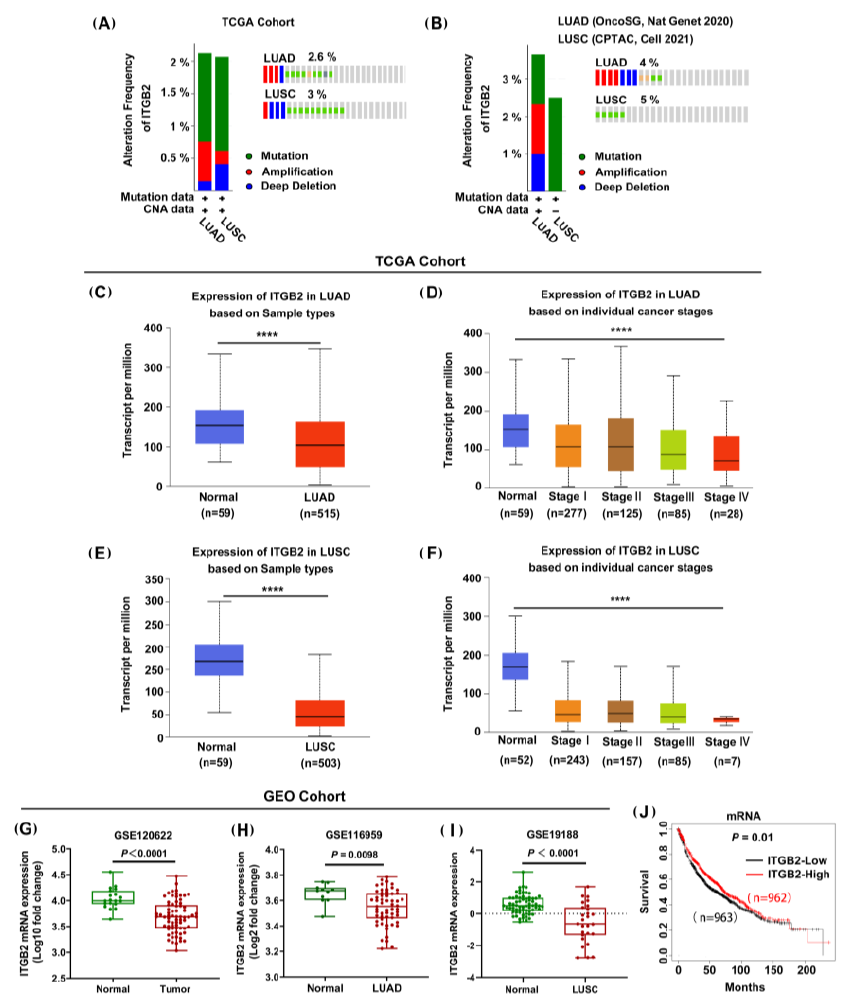
Figure 1. ITGB2 expression was downregulated in NSCLC, and its low levels were associated with a poor prognosis in the public databases. ( A , B ) Genetic changes in ITGB2, analyzed by cBioPortal, based on the TCGA lung cancer dataset ( A ) and OncoSG and CPTAC datasets ( B ). ( C , D ) Expression of ITGB2 in LUAD tissue and adjacent normal tissue ( C ) and LUAD of different tumor stages ( D ) in the TCGA database (UCLCAN). ( E , F ) Expression of ITGB2 in LUSC tissue and adjacent normal tissue ( E ) and LUSC of different tumor stages ( F ) in the TCGA database (UCLCAN). ( G – I ) Expression of ITGB2 in NSCLC tissue and adjacent normal tissue ( G ), in LUAD tissue and adjacent normal tissue ( H ), and in LUSC tissue and adjacent normal tissue ( I ) according to the GEO cohort. ( J ) Kaplan − Meier survival curves for the overall survival (OS) according to ITGB2’s expression levels in NSCLC. **** P < 0.0001.